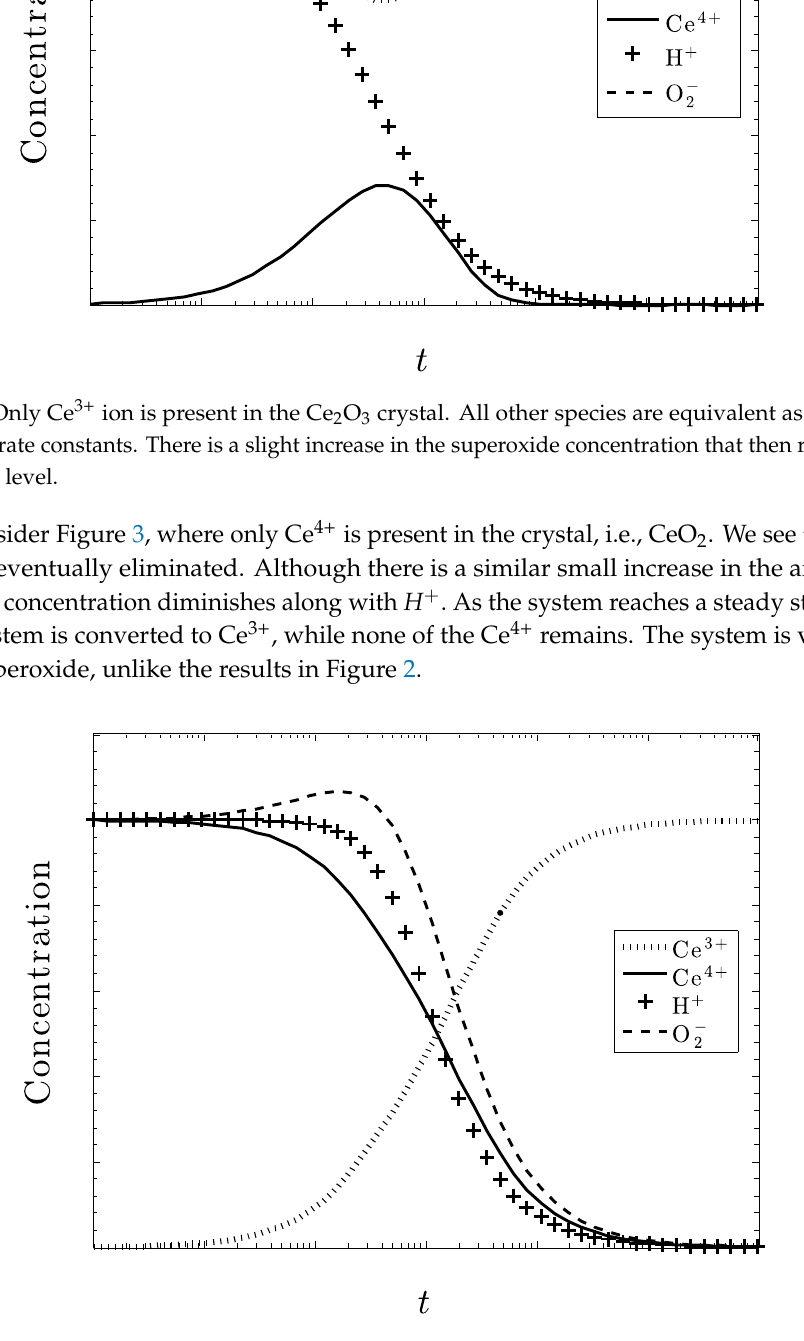
Figure 3. Only Ce 4 + ion present in the CeO 2 crystal. All other species are equivalent as are their respective rate constants. The superoxide concentration is completely eliminated as the system converts to Ce 2 O 3 .